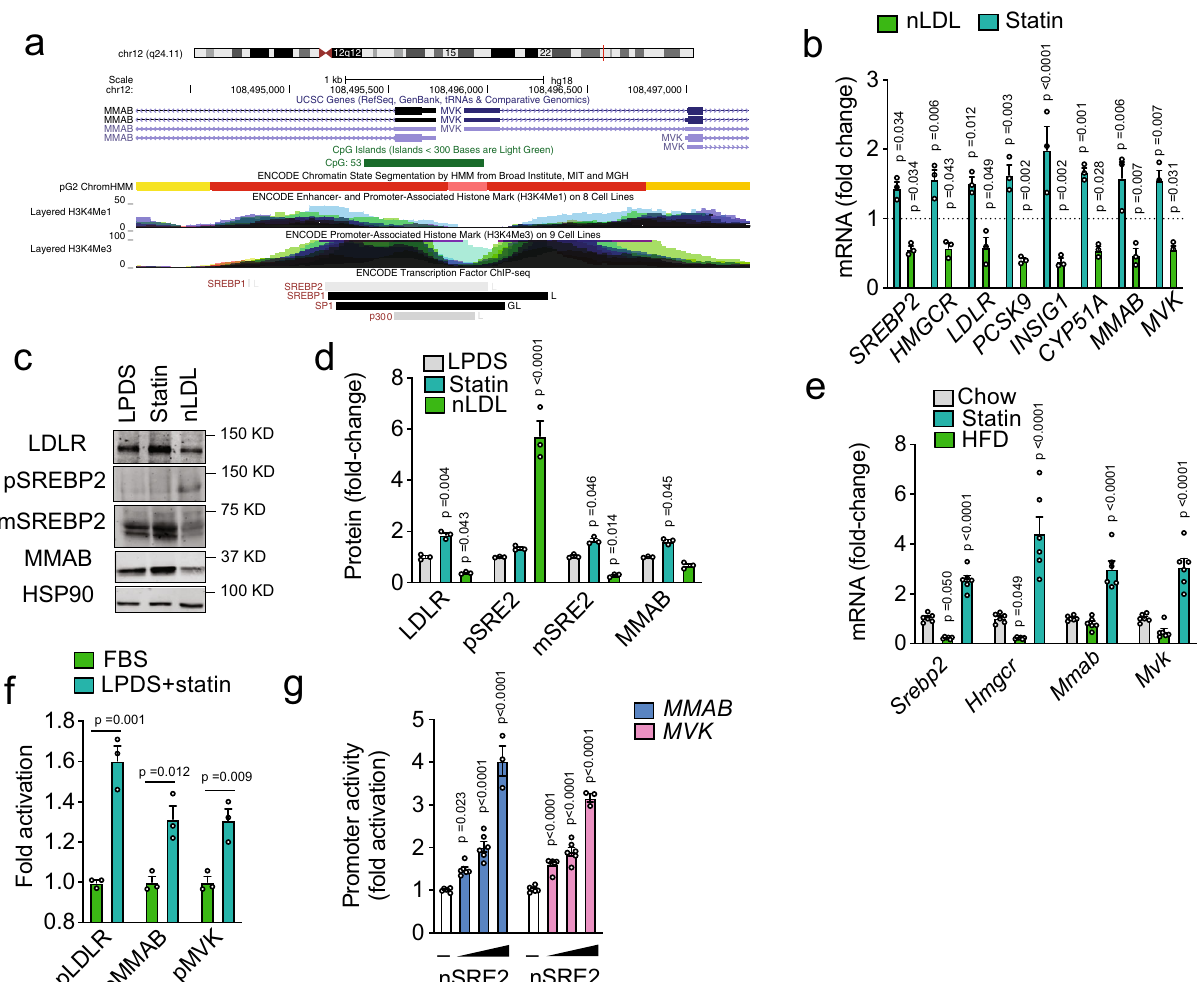
Fig. 3 SREBP2 regulates MMAB/MVK expression in vitro and in vivo. a Schematic diagram of human chromosome 12, showing the localization of MMAB and MVK . The active promoter region of MMAB and MVK is shown in red (HepG2 ChromHMM) and correlates with CpG islands (green) and enriched H3K4Me3 marks. Transcription factor binding sites (as assayed by ChIP-seq) are shown below. SREBP2, SREBP1, SP1, and p300 are highlighted in red. Data were compiled using the UCSC Genome Browser (NCBI36/hg18, http://genome.ucsc.edu). b qRT-PCR analysis of SREBP2-responsive genes in Huh7 cells incubated in lipoprotein-de fi cient serum (LPDS), LPDS + 5 µ M statin, or LPDS + 120 µ g/ml native LDL (nLDL) for 24 h. Relative expression levels were normalized to those cells incubated in LPDS (dashed line). Data are mean ± s.e.m. of three independent experiments in duplicate. Statistical comparisons by two-way ANOVA with Bonferroni correction for multiple comparisons. c , d Representative Western blot of LDLR, SREBP2, and MMAB in Huh7 cells incubated in lipoprotein-de fi cient serum (LPDS), LPDS + 5 µ M statin, or LPDS + 120 µ g/ml native LDL (nLDL) for 24 h. HSP90 was used as a loading control. Quanti fi cation of blot shown in panel ( d ). Data are mean ± s.e.m. of three independent experiments. Statistical comparisons by two-way ANOVA with Bonferroni correction for multiple comparisons. e qRT-PCR analysis of SREBP2-responsive genes in the livers of C57BL/6 mice fed a chow diet, chow diet supplemented with statin (statin) or high-fat diet (HFD). Data are mean ± s.e.m. n = 6 mice per group. Statistical comparisons by two-way ANOVA with Bonferroni correction for multiple comparisons. f MMAB , MVK and LDLR promoter activity in Huh7 cells incubated in 20% FBS + 60 µ g/ml native LDL (nLDL) or LPDS and 5 µ M statin for 24 h (LPDS + statin). Data are mean ± s.e.m. of three independent experiments in triplicate. Statistical comparisons by two-sided unpaired Student ’ s t test. g MMAB and MVK promoter activity in HeLa cells transfected with an empty vector ( – ) or 0.5, 1, and 2 μ g nuclear SREBP2 (nSRE2). Data are mean ± s.e.m. of six independent experiments in duplicate. Statistical comparisons by one-way ANOVA with Bonferroni correction for multiple comparisons. Source data are provided as a Source Data fi